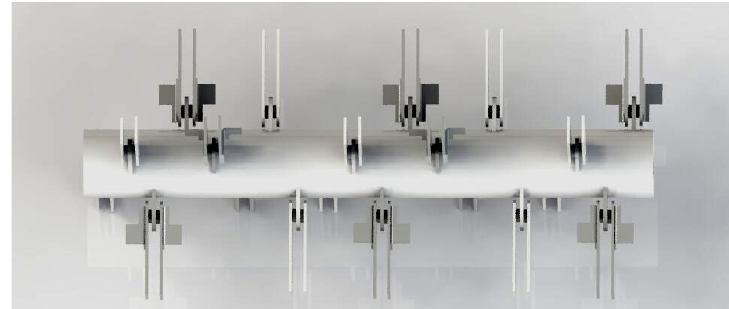
Figure 16. Distribution of wind blades when E = 20.